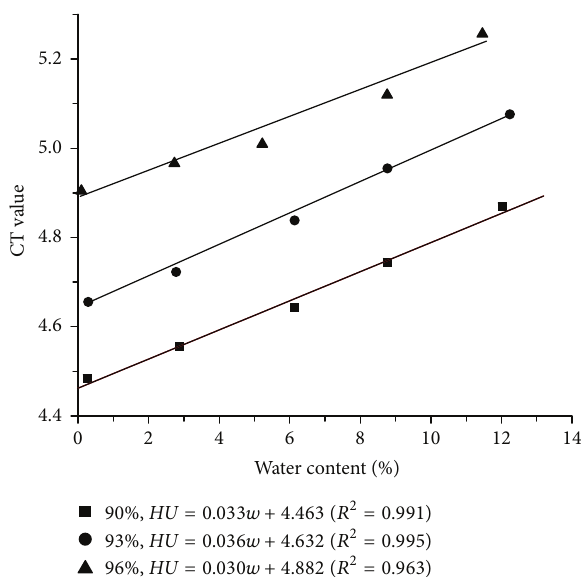
Figure 2: Relationship between water content and CT value at dif- ferent degrees of